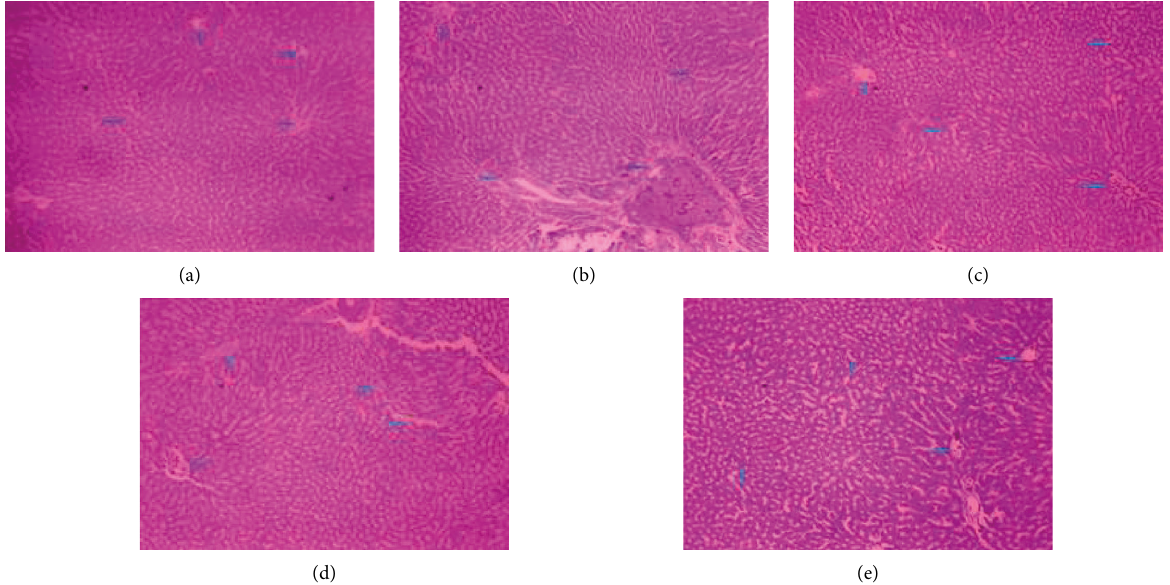
Figure 4: Histopathological examination of rat liver from control group (a), diseased control (b), standard drug treated (c), MEOAA (250 and 500mg/kg) treated groups (d and e) in paracetamol-induced hepatotoxicity. (a) Control group showed normal hepatic architecture. No inflammation, hydropic degeneration, fibrosis, necrosis, atypia, steatosis, or malignancy were seen, (b) diseased rat liver revealed gross hydropic degeneration, steatosis, and necrosis of hepatocytes. However, some areas showed periportal fibrosis with adjacent aggregates of lymphocytes with neutrophilic inflammation, (c) standard drug-treated group showed near to normal parenchymal architecture of hepatic plates with some areas of hepatocytic vacuolation. No atypia and malignancy was seen, (d) MEOAA (250 mg/kg) treatment showed mild degeneration of hepatocytes and central veins dilation. Sinusoids were dilated and congested. Liver tissue showed apoptotic changes. No atypia and malignancy was seen, (e) MEOAA (500 mg/kg) treatment represents normal hepatic architecture. Regeneration of hepatic cells was observed. No atypia or malignancy was